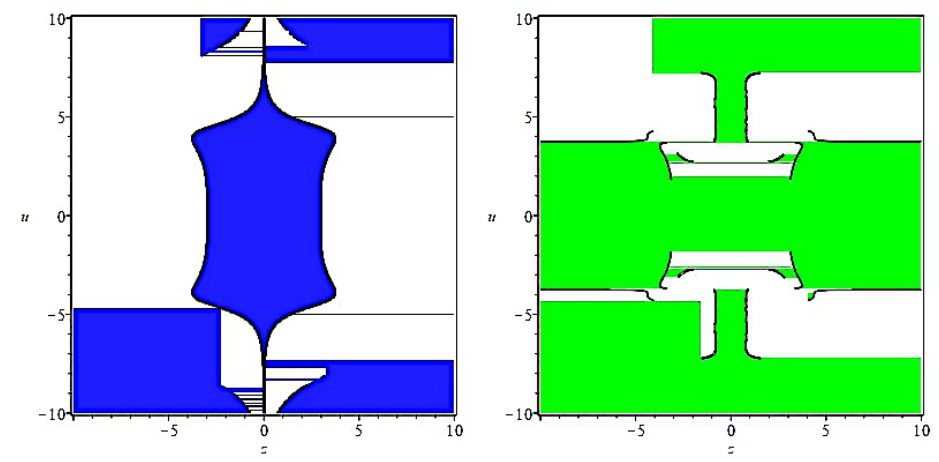
Figure 1. z − u stability region of BFFM for k = 2 ( left ) and k = 3 ( right ) for the Lambert-Watson test.